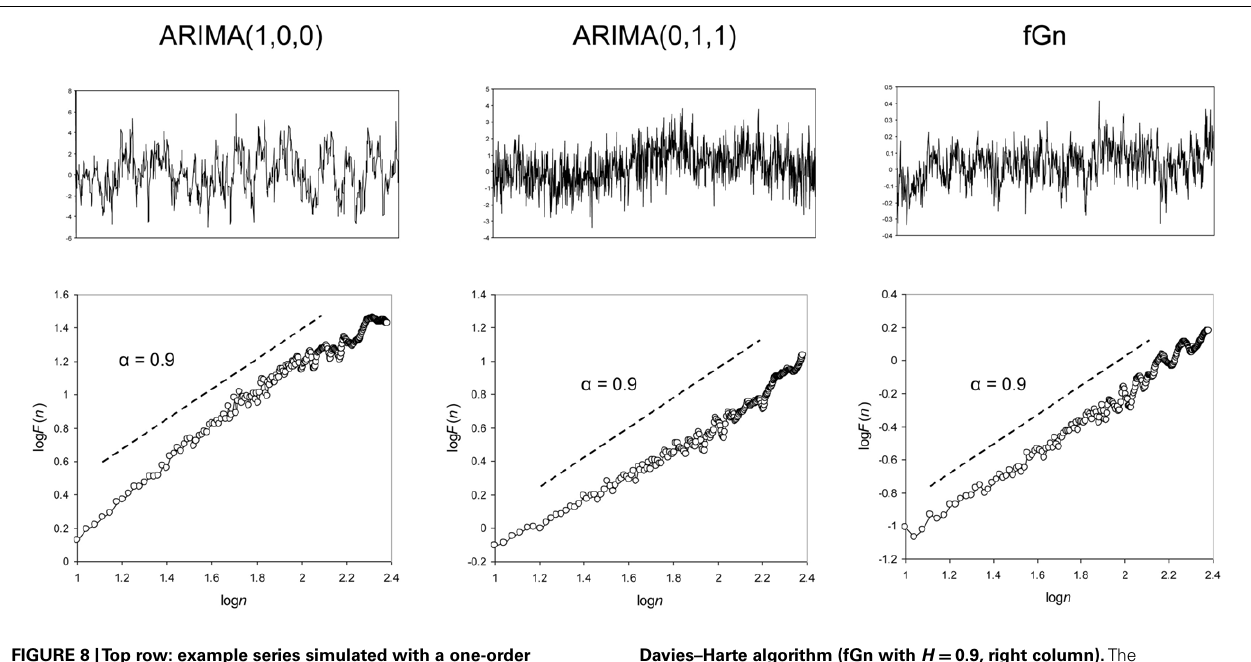
Davies–Harte algorithm (fGn with H = 0.9, right column). The corresponding DFA diffusion plots are presented in the bottom